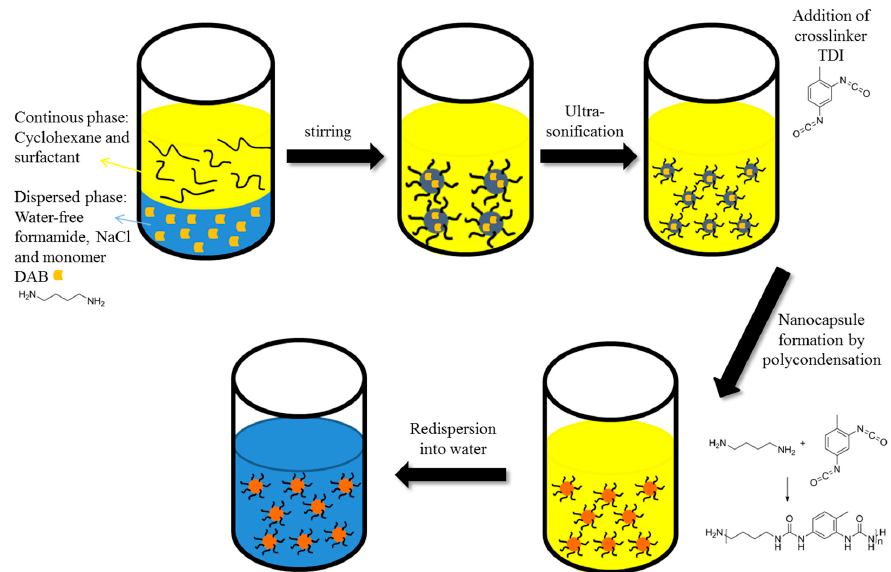
Figure 2. Procedure of an inverse miniemulsion with 1,4-diaminobutane (DAB) and toluene-2,4-diisocyanate (TDI) as monomers to generate polyurea (PU) nanocapsules and their re-dispersion into water.